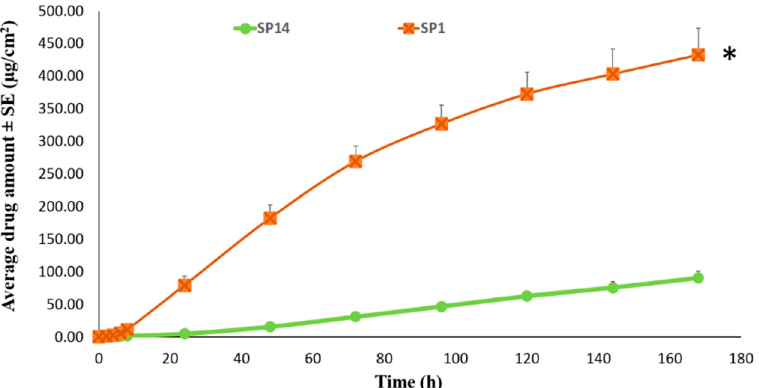
Figure 7. Comparison of permeation profile of silicone and PIB based TAF patches through human epidermis. * Represents statistical significant difference, Student’s t test ( p < 0.05). SP1: Silicone based 15% TAF patch. SP14: Poly isobutylene based 15% TAF patch.